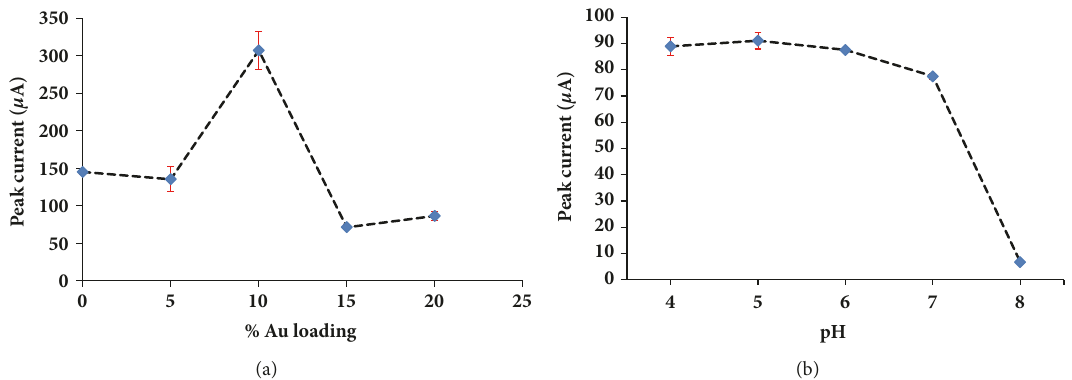
Figure 4: (a) Effect of gold loading on supported material on the anodic peak currents of 1 mM uric acid detection. (b) Effect of pH on the anodic peak currents of 1 mM uric acid detection.